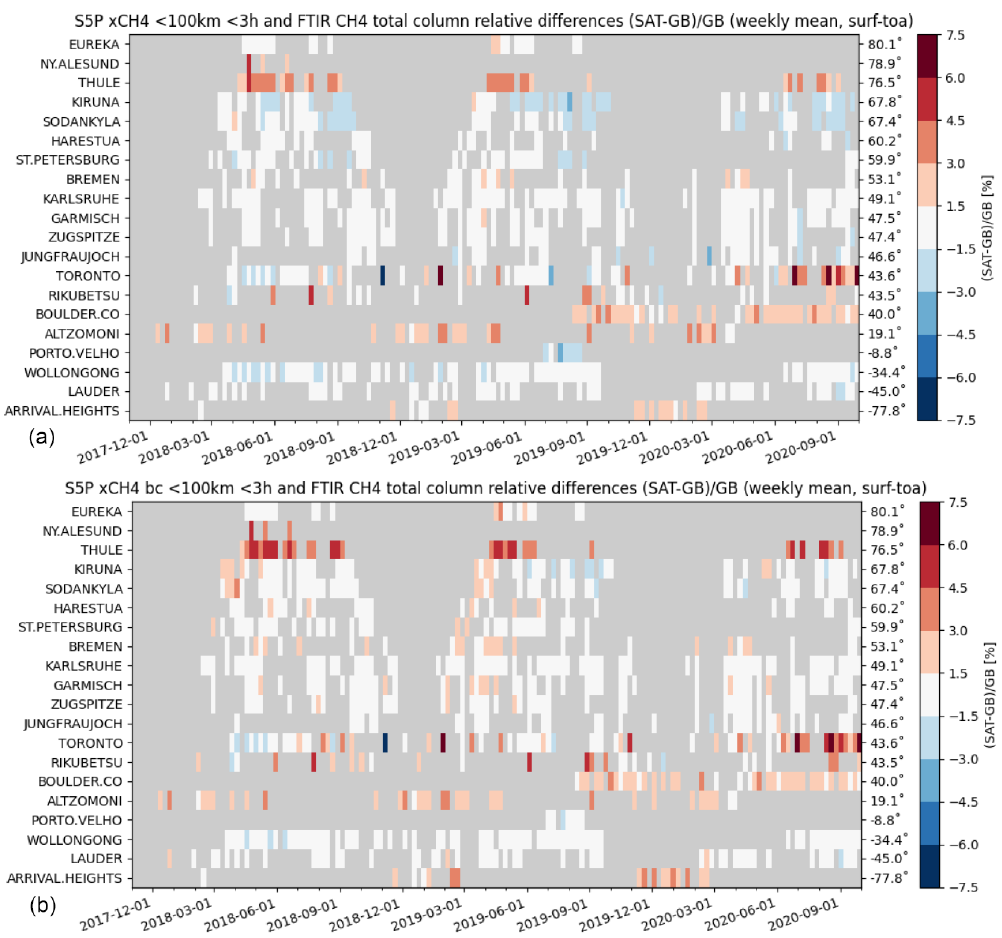
Figure 11. Mosaic plots showing relative biases between co-located S5P (standard XCH 4 product – a ; bias-corrected XCH 4 product – b ) and NDACC XCH 4 data smoothed with S5P a priori and additionally smoothed with the S5P column-averaging kernel at 20 NDACC stations within the period between November 2017 and September 2020. Spatial co-location with radius of 100km and time of ± 3h around the satellite overpass was used. The time resolution of the data shown here is weekly. The stations are sorted with decreasing